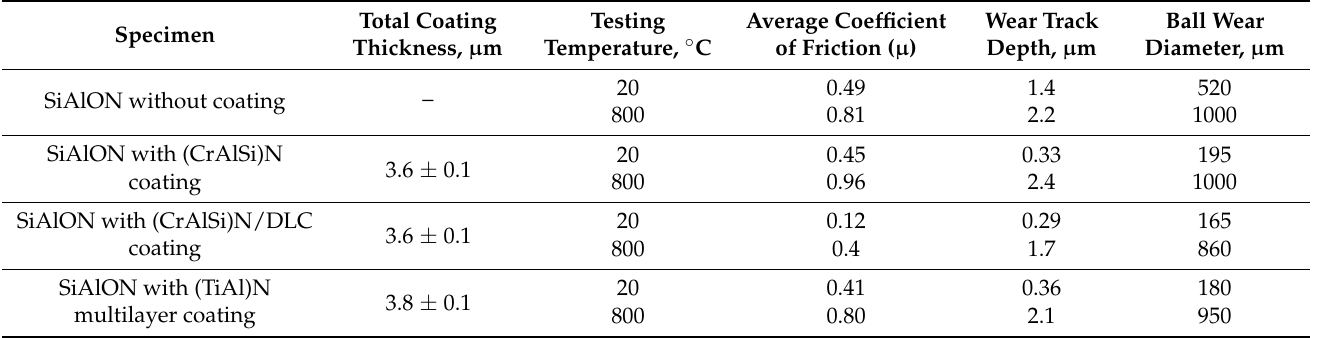
Table 3. Results of preliminary tribological tests of 80% (90 α 10 β ) + 20% TiN ceramic specimens with different coatings.